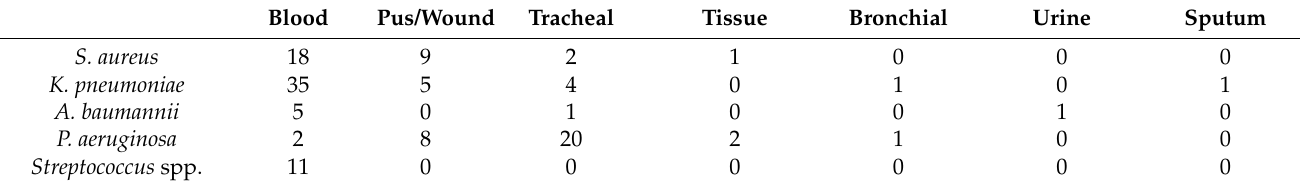
Table 2. Distribution of isolated bacteria across various infected body